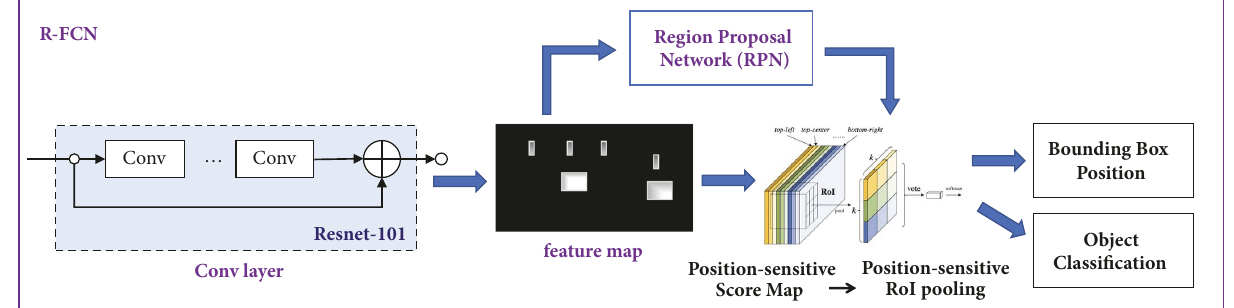
Figure 4: Block diagram of R-FCN network model with Resnet-101.